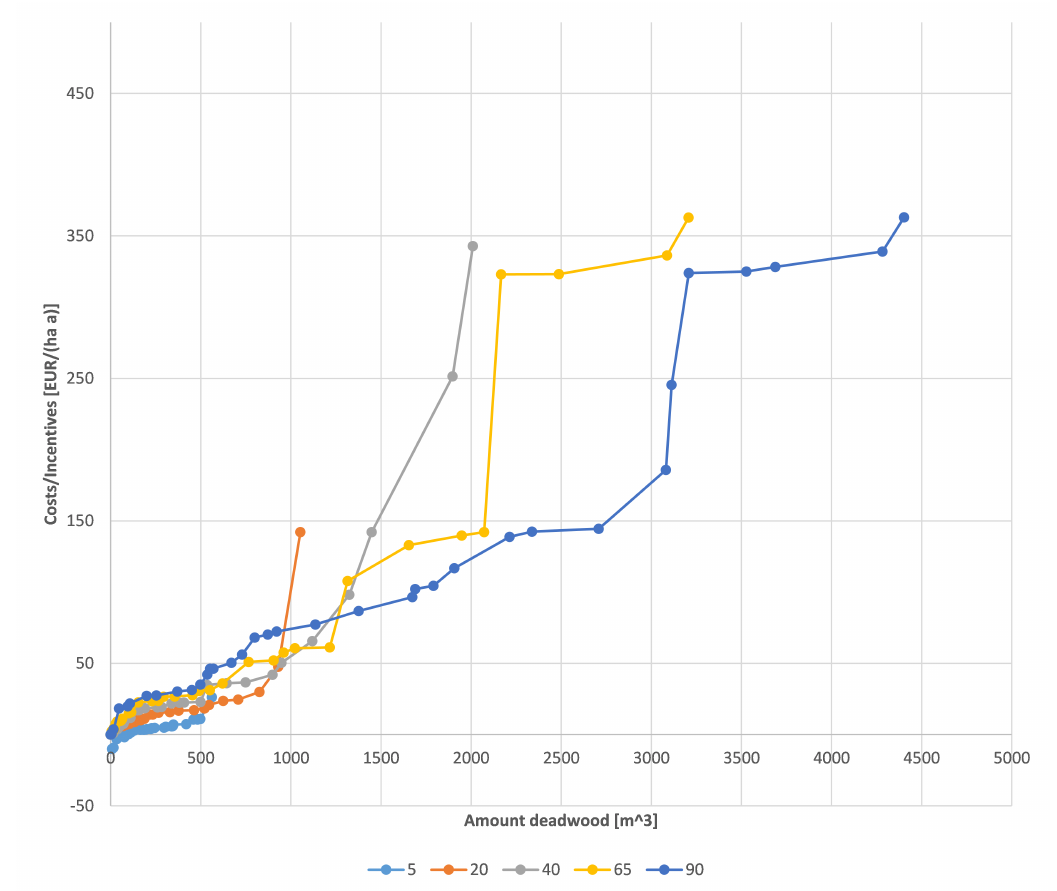
Figure 9. Forest enterprise “Eichelberg”: Costs or necessary compensations (incentives) in [ e ha − 1 a − 1 ] of absolute deadwood amounts in [m 3 ], to be maintained within 30 years, using heavy timber of beech. The different colours correspond to the average deadwood volume from 5m 3 ha − 1 to 90m 3 ha − 1